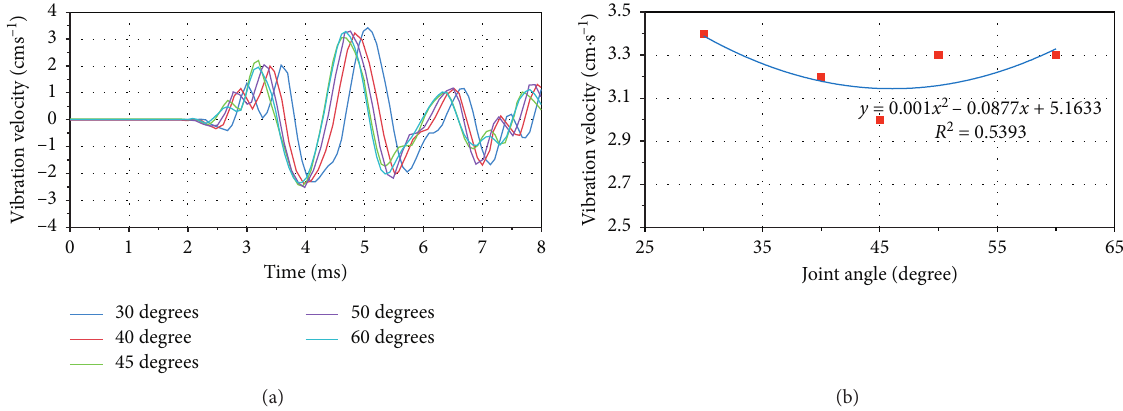
Figure 13: Relationships between vibration velocity and joint angles. (a) Velocity history curves with different joint angles of plates. (b) Fitting curves of vibration velocity with different joint